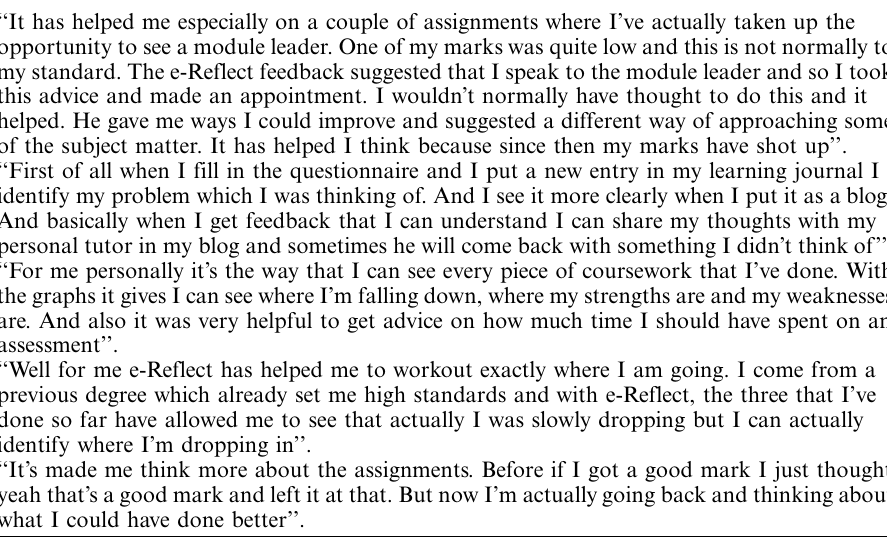
Table 1. Student comments on the MAC